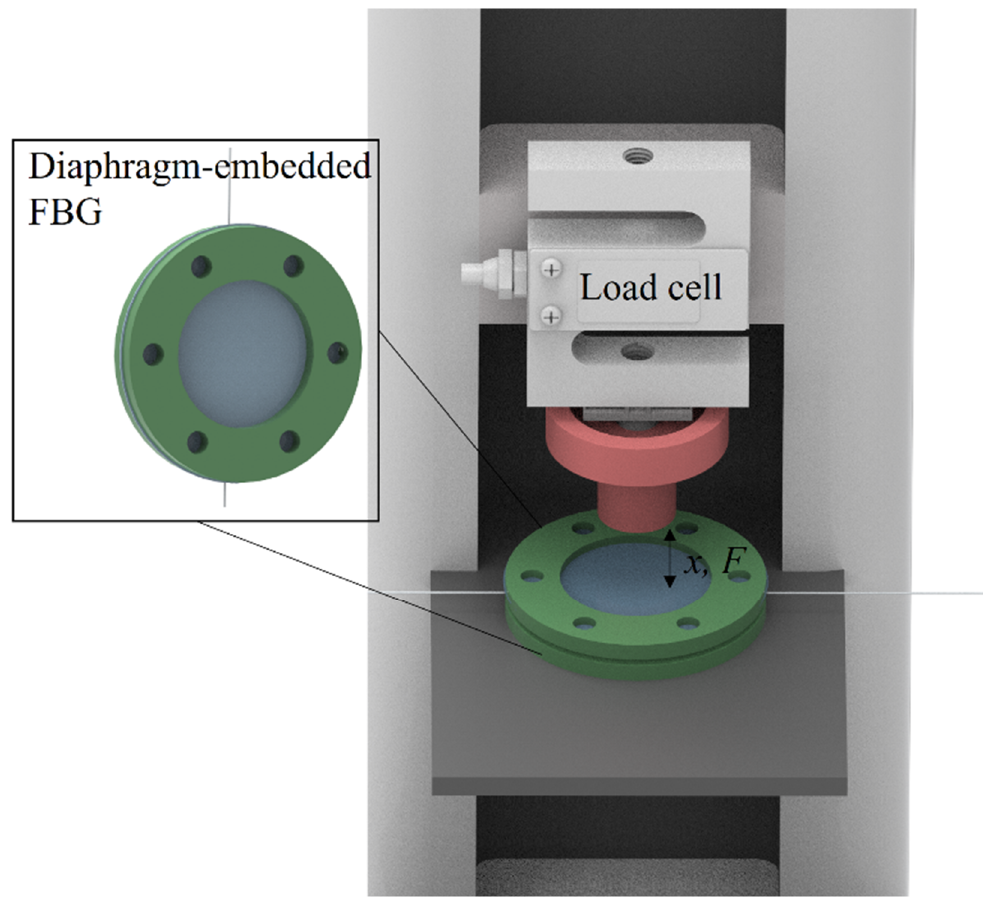
Figure 2. Experimental setup for force and displacement assessment. Figure inset shows the dia- phragm structure. aphragm